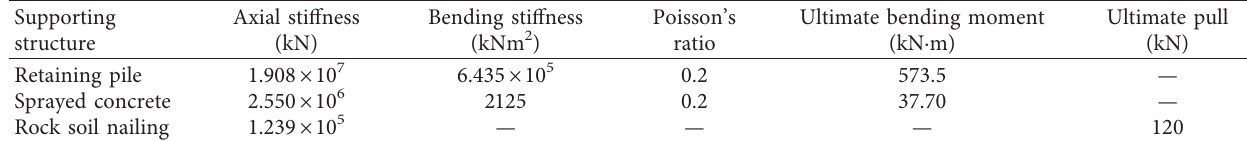
Table 3: Support structure